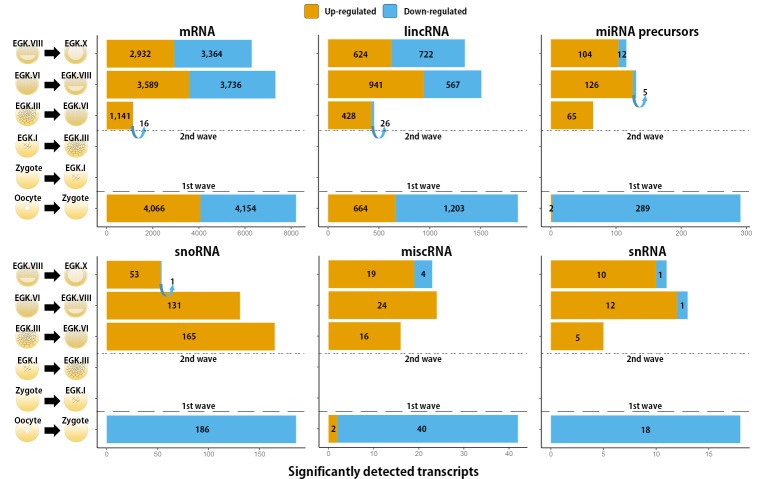
Transcripts that undergo a detected change in expression between each stage during chicken early development.The number of differentially expressed mRNAs, lincRNAs, miRNA precursors, snoRNAs, miscRNAs and snRNAs was detected using either Ensembl gene annotation or the ALDB database. The orange and blue colors represent up- and downregulated genes at FDR-adjusted p<0.05, respectively.